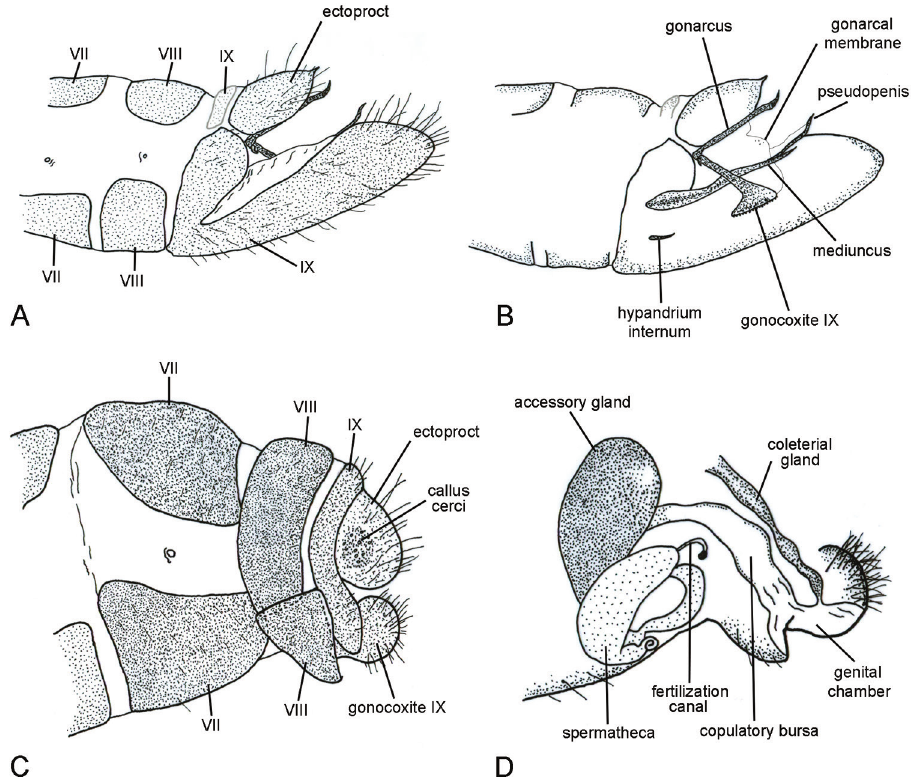
Figure 5. Last abdominal segments of Nolima victor , lateral. A male external morphology B male inter- nal morphology C female external morphology D female internal